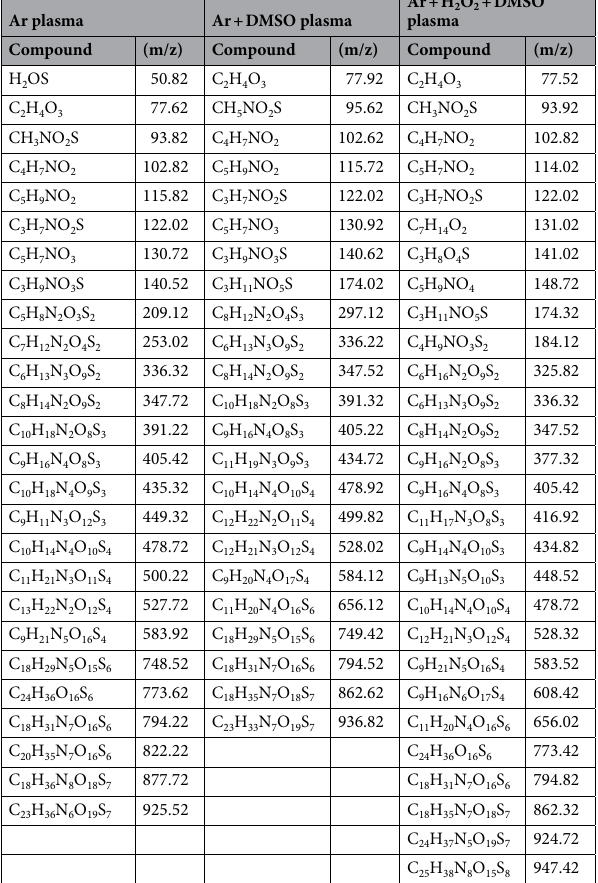
Table 1. The m/z [M–H] + values of major cysteine derivatives induced under different plasma treatments.